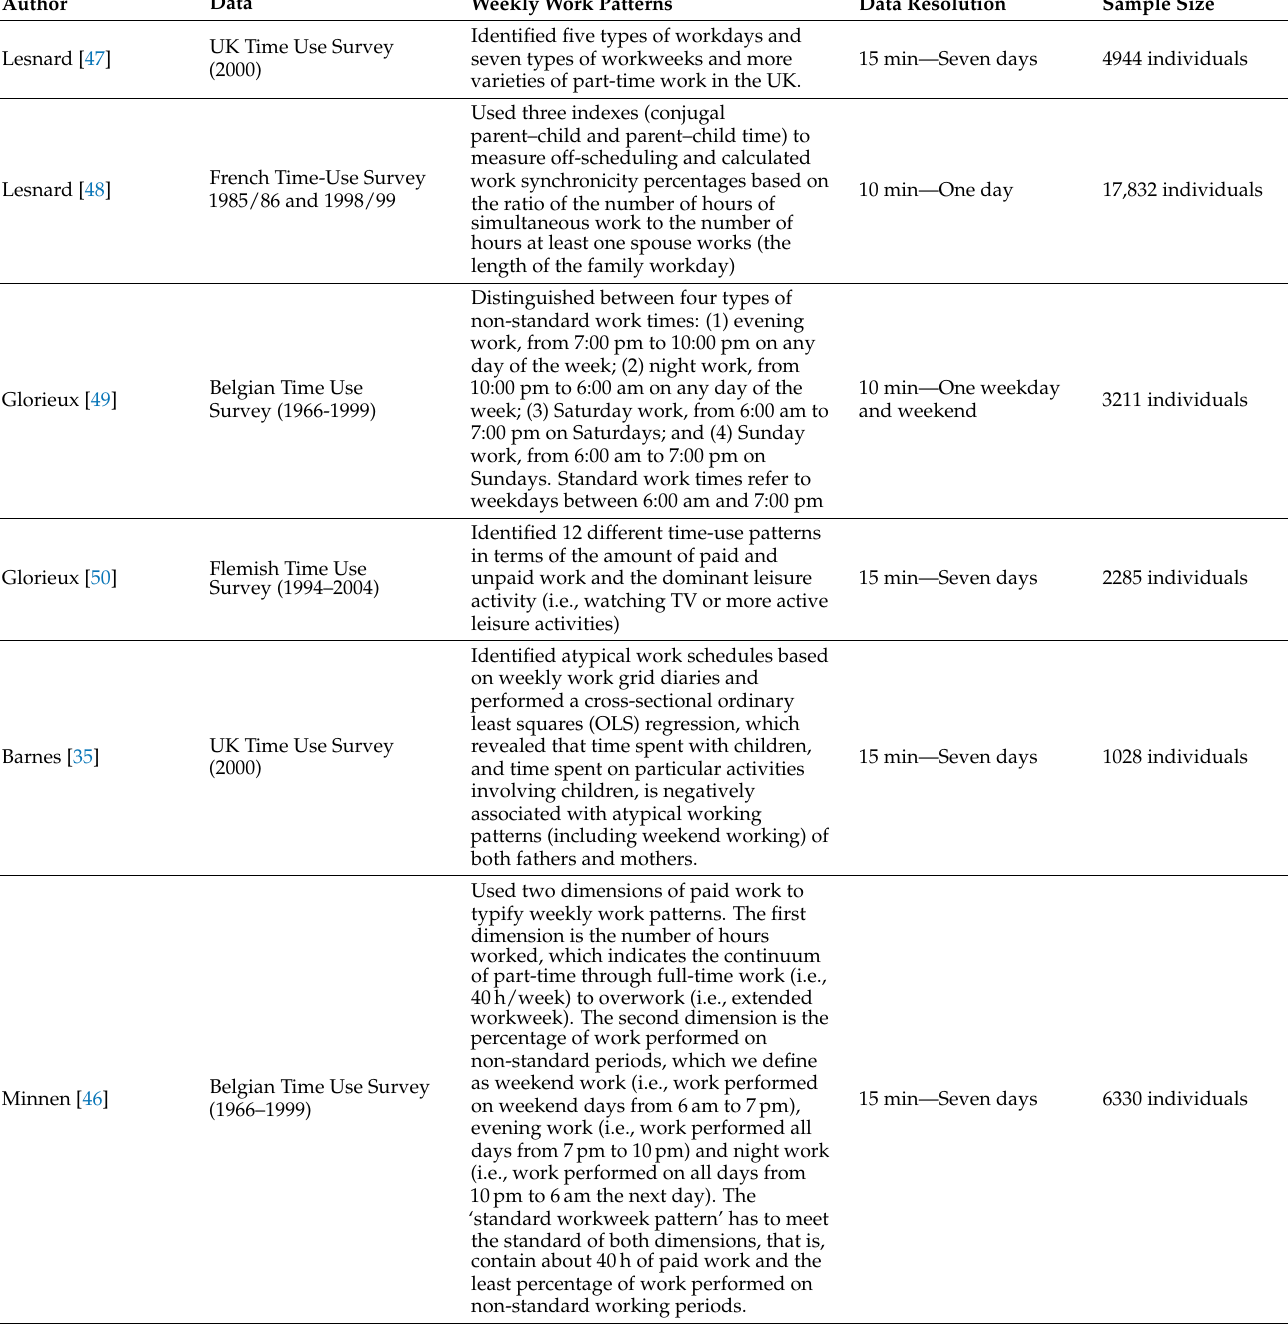
Table A1. Types of work schedules on working